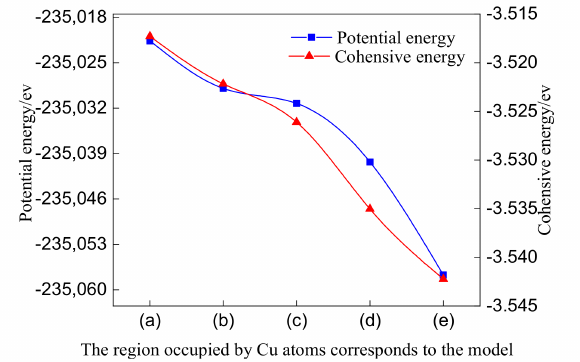
Figure 3. Diagram of the potential energy and the cohesive energy of Cu atoms after the region of Cu atoms is successively